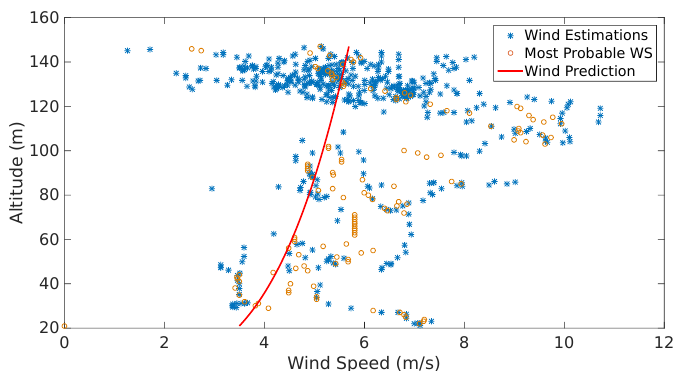
Figure 17. Estimation, most probable wind speeds and last wind prediction generated throughout the flight illustrated in Figure